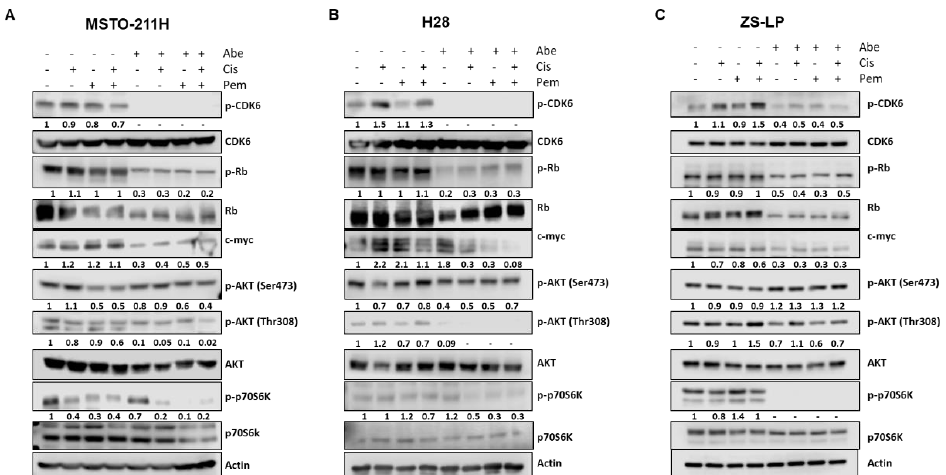
Figure 2. Western blotting analysis of the expression level or activation status of proteins involved in the regulation of the cell cycle and in signal transduction pathways. ( A ) MSTO-211H cells were simultaneously treated with abemaciclib (0.5 µ M), cisplatin (0.3 µ M), and pemetrexed (0.02 µ M) for 24 h. ( B ) H28 cells were treated with abemaciclib (1 µ M), cisplatin (1 µ M), and pemetrexed (0.05 µ M) for 24 h. ( C ) ZS-LP cells were treated with abemaciclib (1 µ M), cisplatin (1 µ M), and pemetrexed (0.05 µ M) for 24 h. At the end of the treatments, the expression levels of proteins involved in cell cycle regulation and signal transduction were analyzed by Western blotting. The immunoreactive spots were quantified by densitometric analysis; the results are represented by the ratio between phosphorylated and total protein levels or between the total protein and actin levels. The dash (-) represents a non-detectable signal. Data are representative of two independent experiments. Figure S5: Whole Western blots of Figure 2.